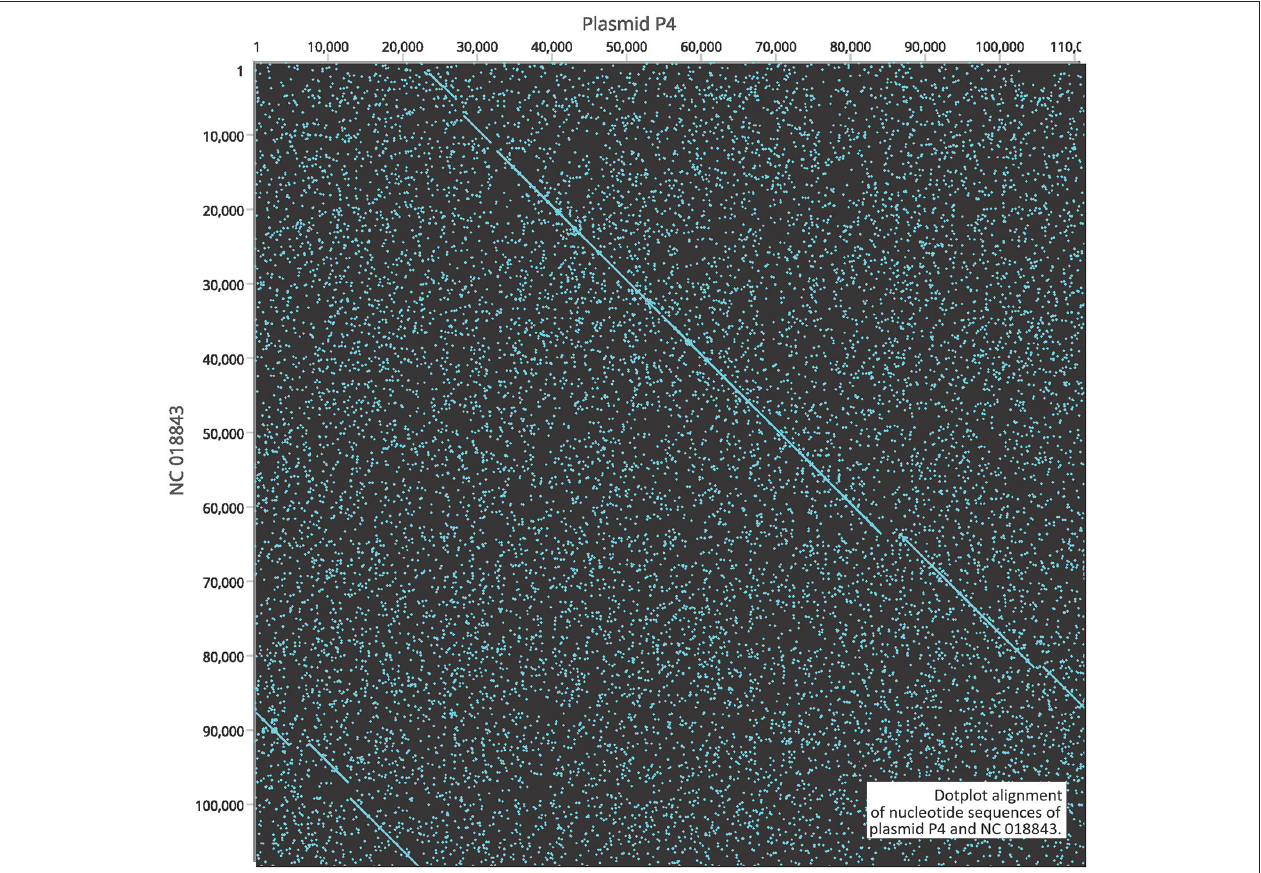
FIGURE 4 | Dotplot alignment of nucleotide sequences of plasmid P4 and NC 018843.